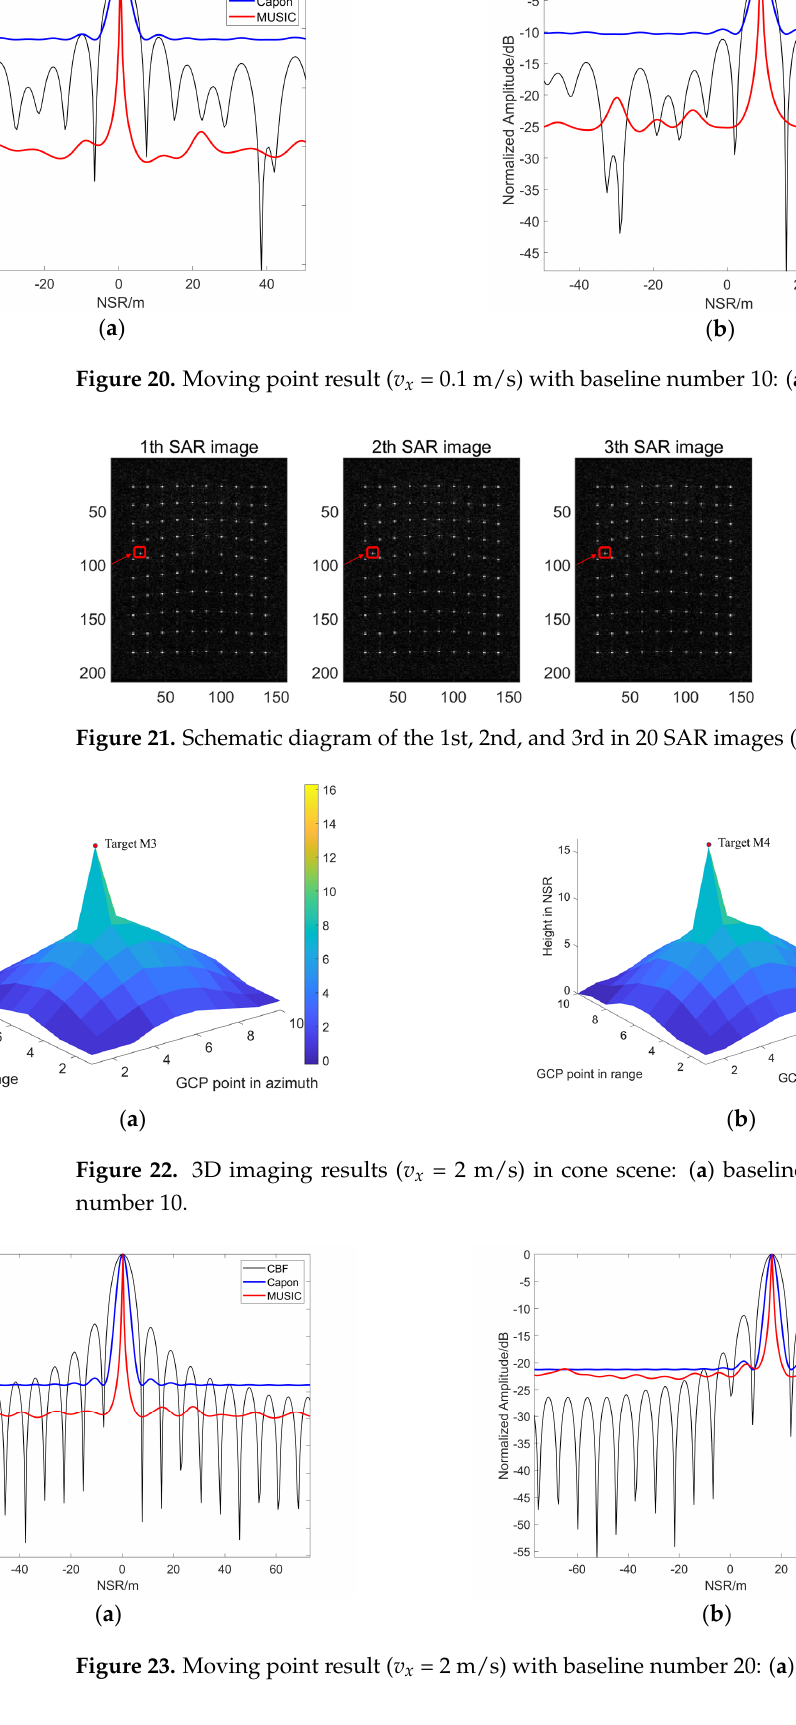
( b ) Figure 24. Moving point result ( v x = 2 m/s) with baseline number 10: ( a ) 1st point; ( b ) 55th point. 3.3. Simulation Evaluation We set 100 GCP points 3D imaging time and employed the root means square error (RMSE) as the evaluation condition (performance shown in the Table 4): 2 1 ( )ˆ1 si siM i RMSE M      